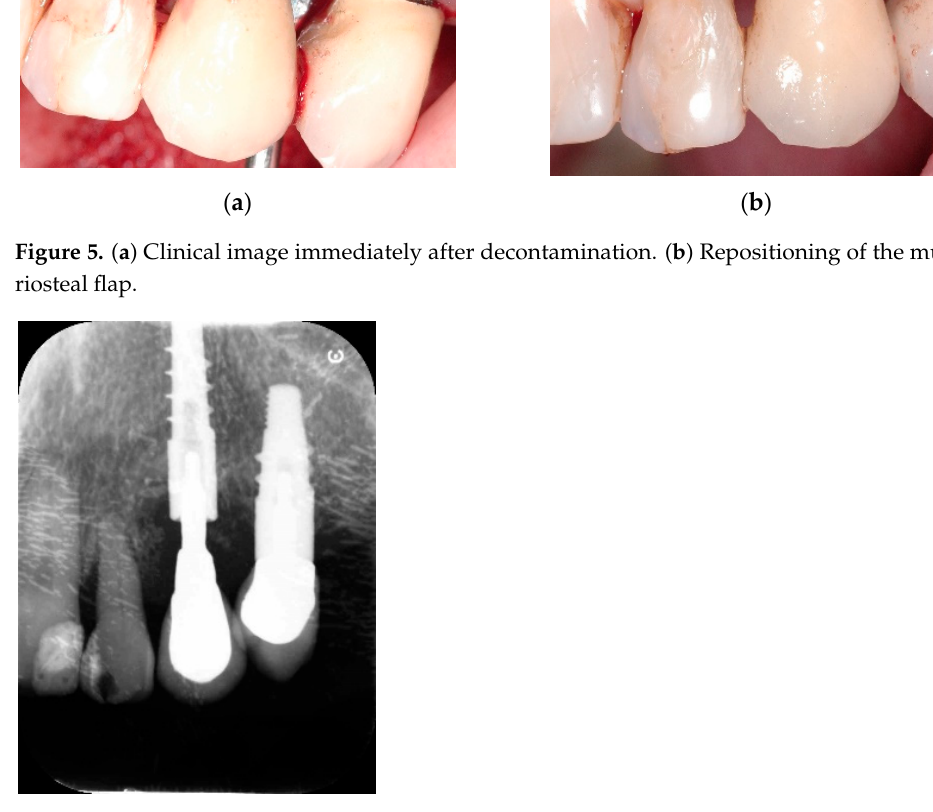
Figure 6. Endoral X-ray taken 3 months after treatment.